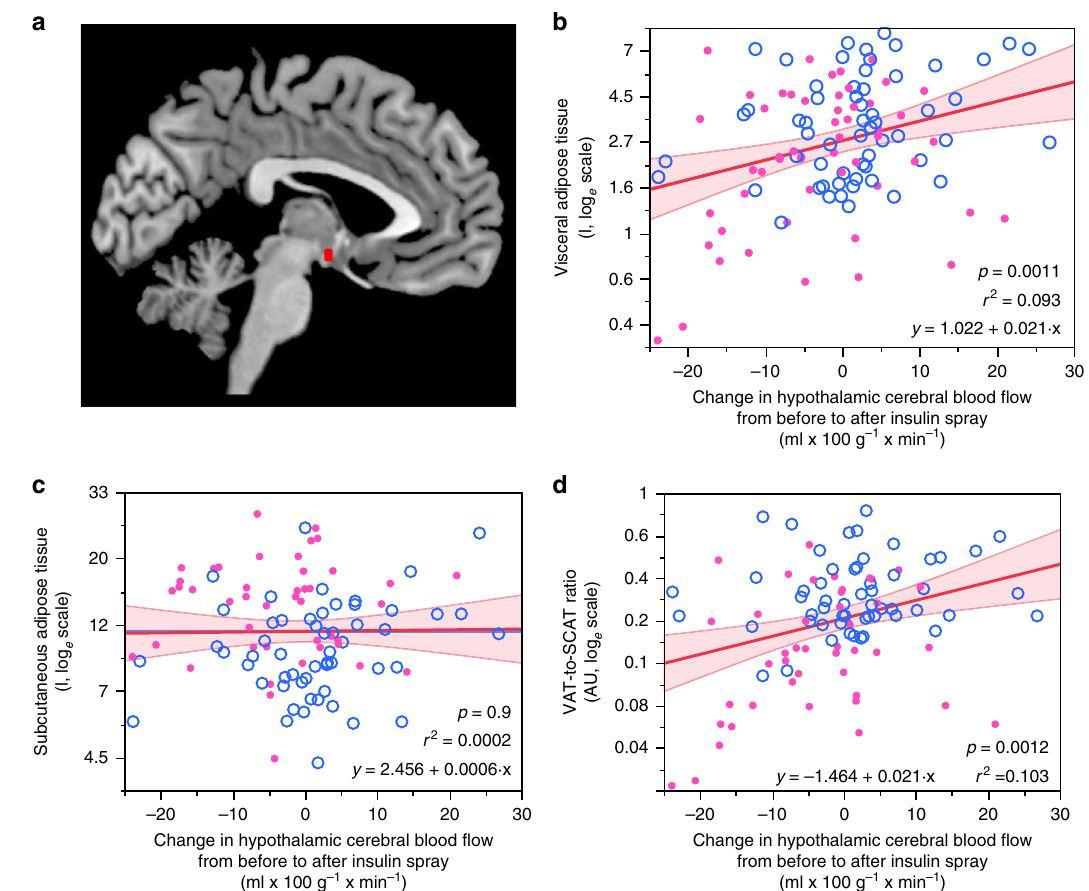
Fig. 2 Hypothalamic insulin responsiveness associates with body fat distribution. Region-speci fi c change in cerebral blood fl ow in response to intranasal insulin administration was extracted for the hypothalamus as region of interest ( a ). Participants with a strong insulin-induced suppression in hypothalamic blood fl ow had signi fi cantly less visceral adipose tissue ( b ). Subcutaneous fat content was not associated with insulin sensitivity of the hypothalamus ( c ). The ratio of visceral to subcutaneous adipose tissue was favorably lower in those with strong insulin-induced hypothalamic blood fl ow ( d ). Pink fi lled circles are female participants ( N = 53), open blue circles are males ( N = 59). Lines represent fi t lines ±CI. p values are from unadjusted linear regression models. Source data are provided as a Source Data fi